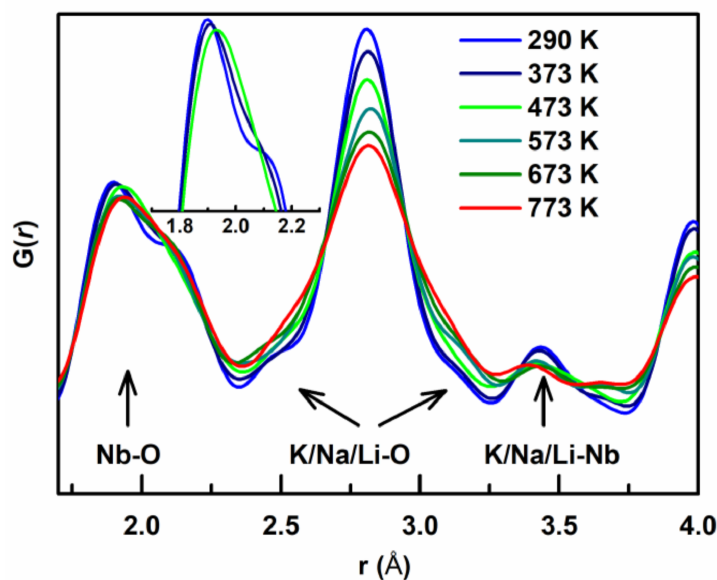
Figure 4. Temperature-dependent evolution of G( r ), showing nearest neighbor pairwise atomic correlations. Peaks representing Nb-O, K/Na/Li-O, and K/Na/Li-Nb bond lengths are marked with